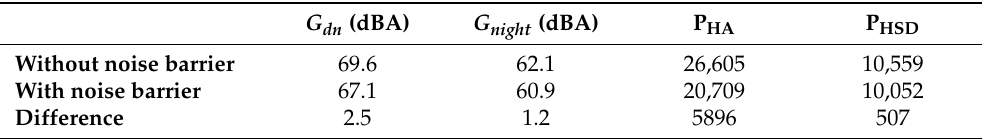
Table 9. G dn , G night , P HA , and P HSD for the University Town. G dn (dBA) G night (dBA) P HA P HSD Without noise